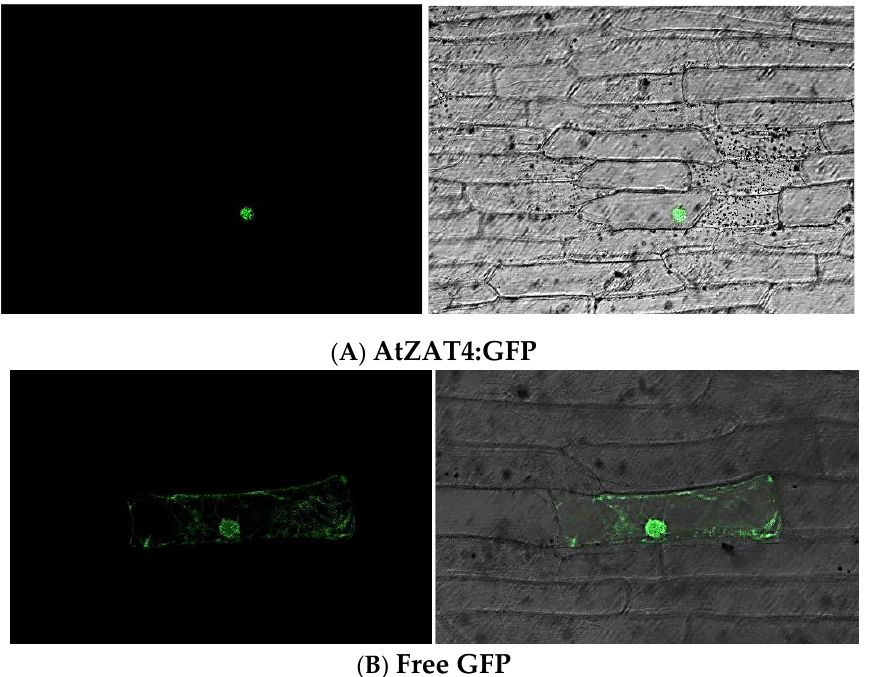
Figure 2. Subcellular localization of the AtZAT4 protein. ( A ) AtZAT4:GFP or ( B ) constructs carrying GFP were bombarded into onion epidermal cells. GFP and AtZAT4:GFP fusion proteins were under the control of the CaMV 35S promoter. After the bombardment, the samples were incubated for 24 h at 22 °C in the dark (left column) and then visualized by a confocal microscope (right column). Each experiment was done in triplicate resulting in the same fluorescence pattern. Bar = 100 µm. For details, see the Materials and Methods section.